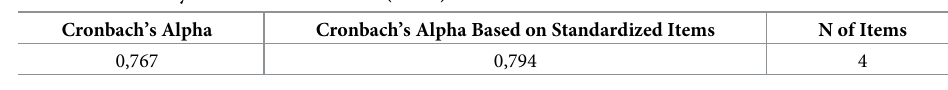
Table 18. Reliability statistics for subscale 4 (DLGs).